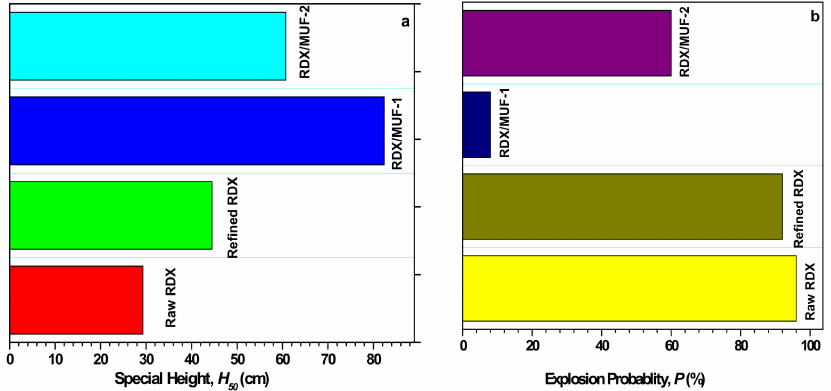
Figure 8. Sensitivity histograms for di ff erent RDX samples: ( a ) impact sensitivity, ( b ) friction